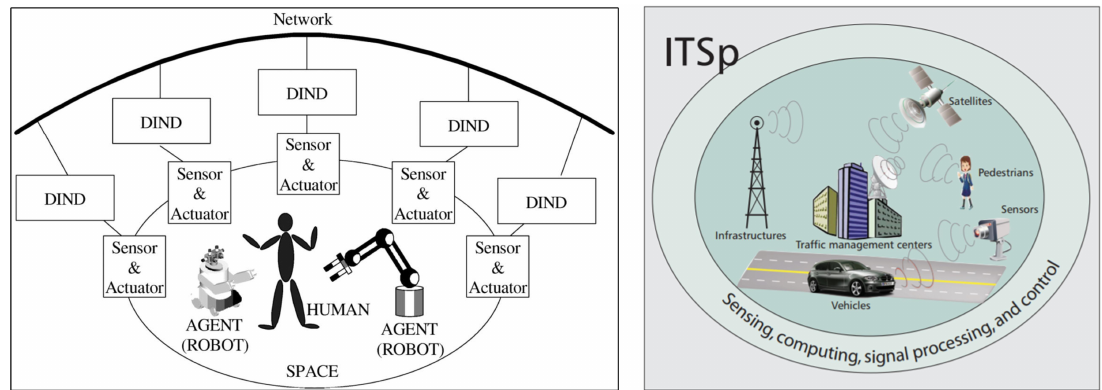
Figure 7. Conceptual figure of intelligent space and intelligent transportation space. The left figure shows intelligent space [51,55], in which the DIND means Distributed Intelligent Network Device; the right figure is the intelligent transportation space